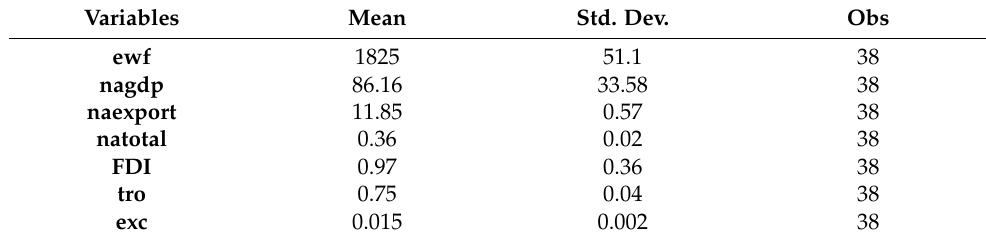
Table 1. Summary statistics.